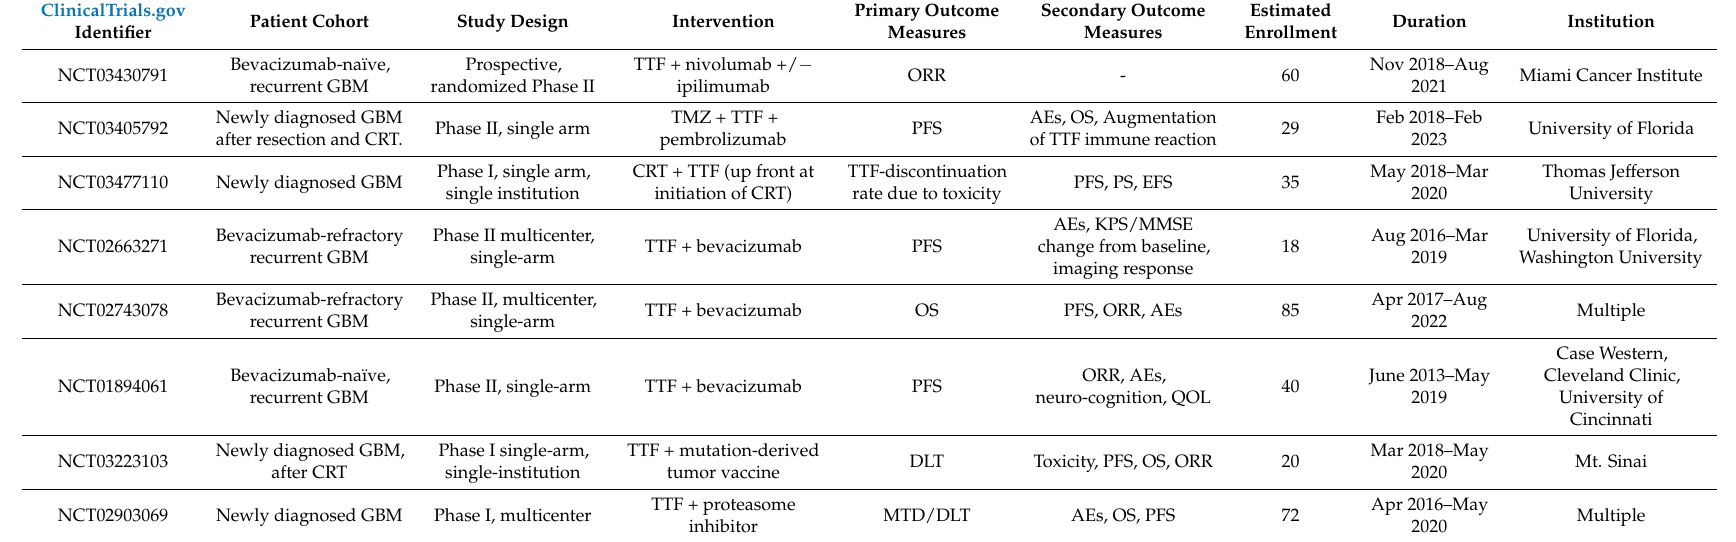
Table 2. Ongoing trials using TTF for GBM as of December 2018 1